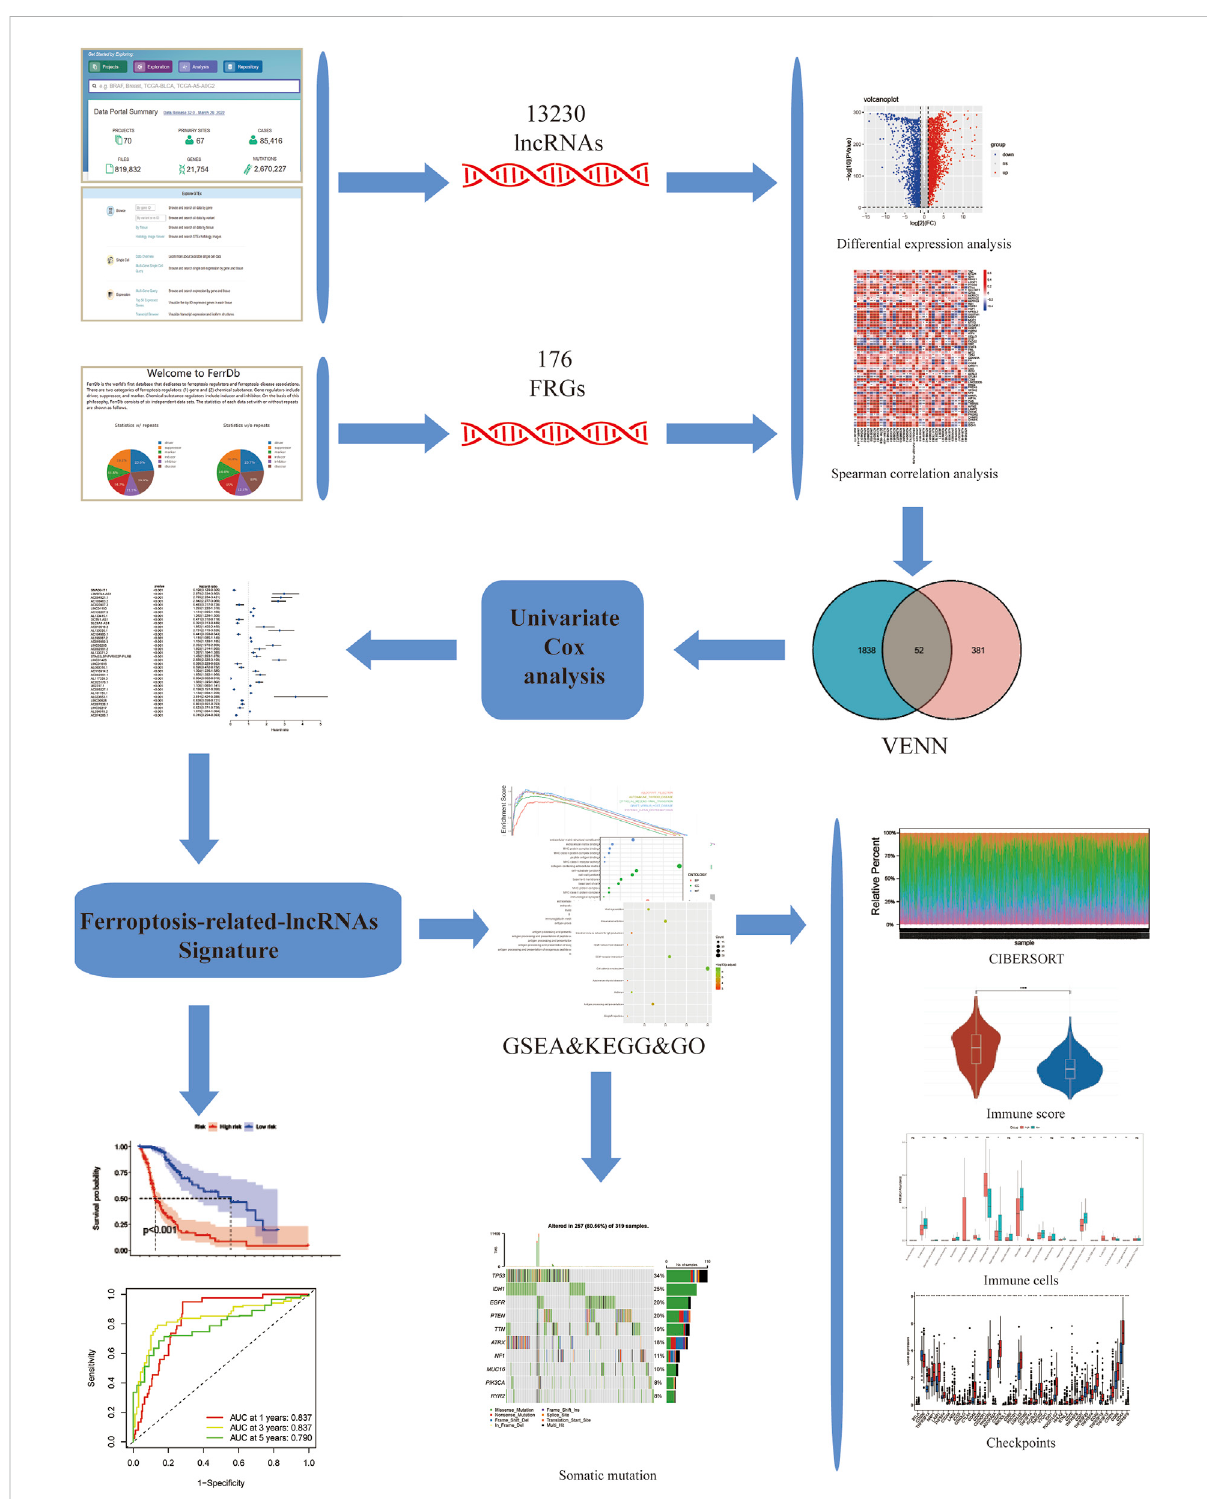
FIGURE 1 Study fl owchart.13,230LncRNAswere obtained from TCGA and GTEx databases. 176ferroptosis-related genes (FRGs) wereobtained from the FerrDb database. Then, 433 ferroptosis-related lncRNAs (FRLs) were identi fi ed according to Spearman correlation analysis. Next, univariate COX analysis was applied to construct a 3-FRL signature. Finally, GSEA, KEGG, GO analysis, immune correlation analysis, somatic mutation analysis were applied to determine the potential function of this